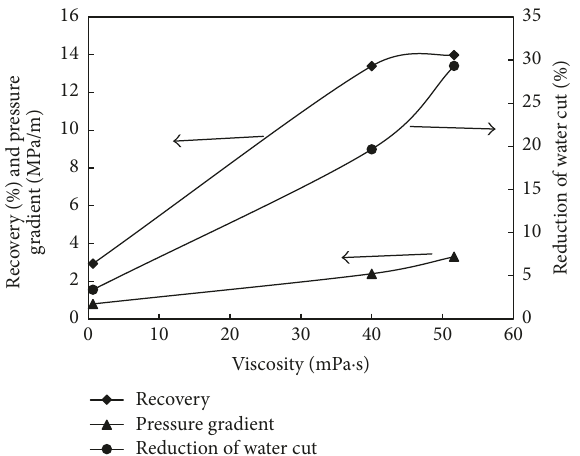
Figure 9: Relationship of separated water ratio and incremental oil recovery when surfactant concentration varies. The polymer concentration is 1500